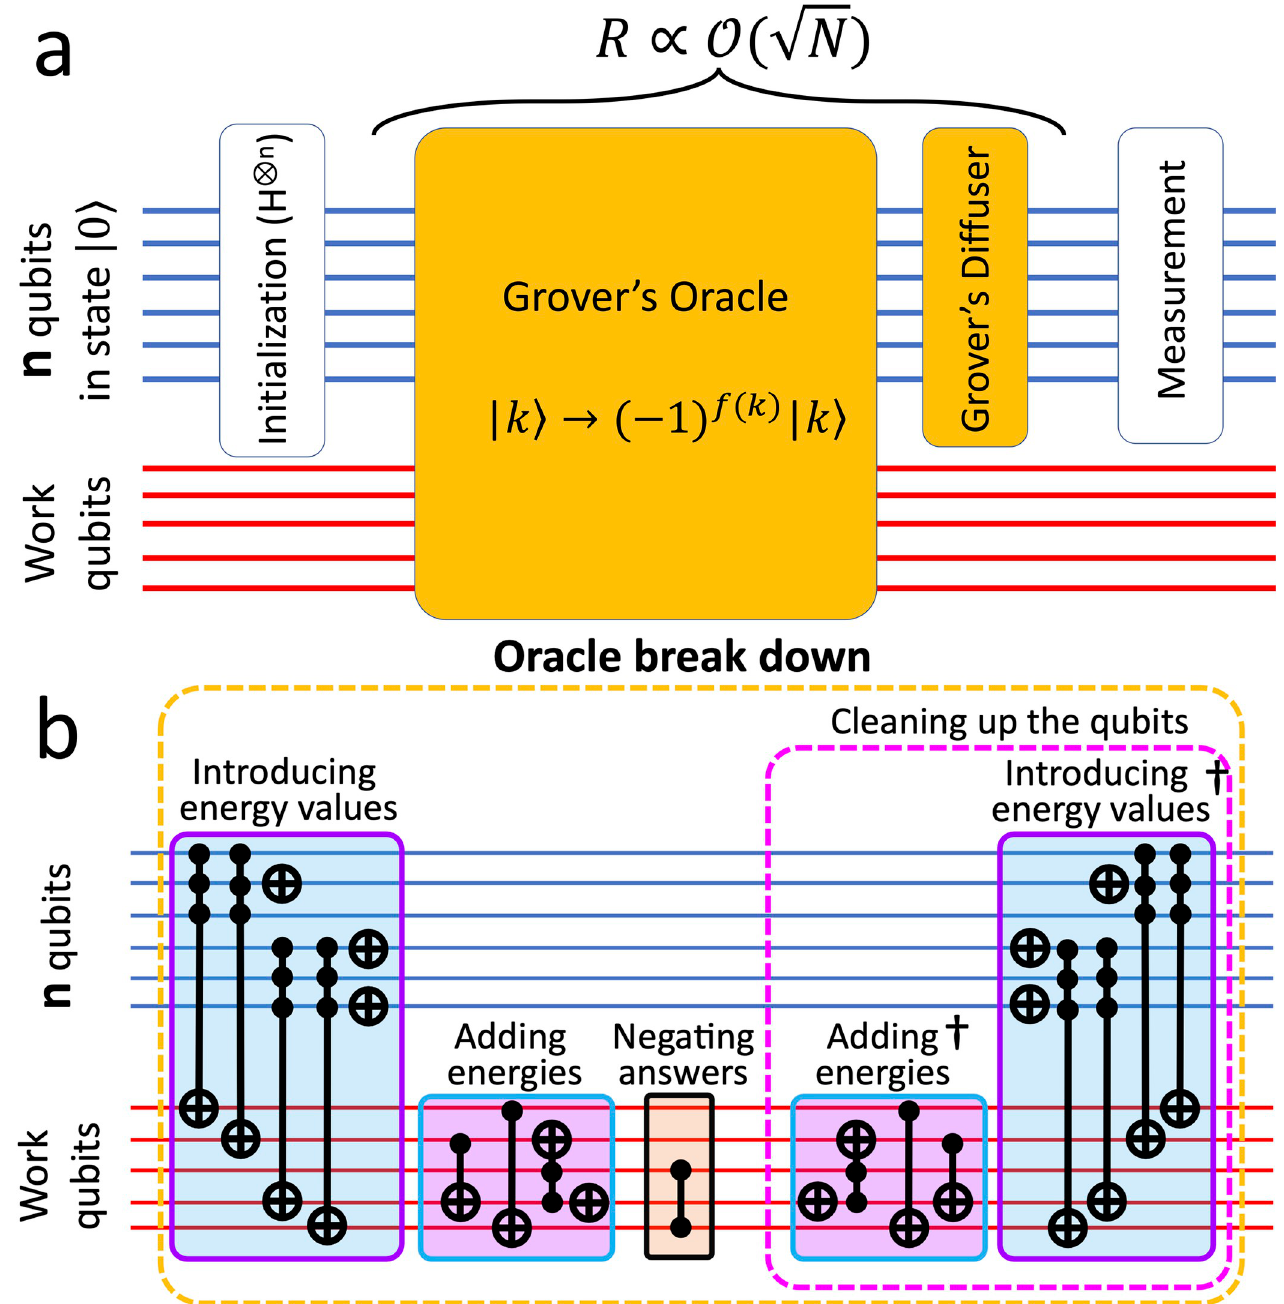
Fig 1. Schematic representation of our circuits. A) Different steps of Grover’s algorithm; B) Different sub-steps implemented in our Oracle. The parallel lines represent qubits. The blue lines show the n qubits and the red lines show the work qubits. In the oracle, if | k i is an answer state, f ( k ) = 1, otherwise it is 0.